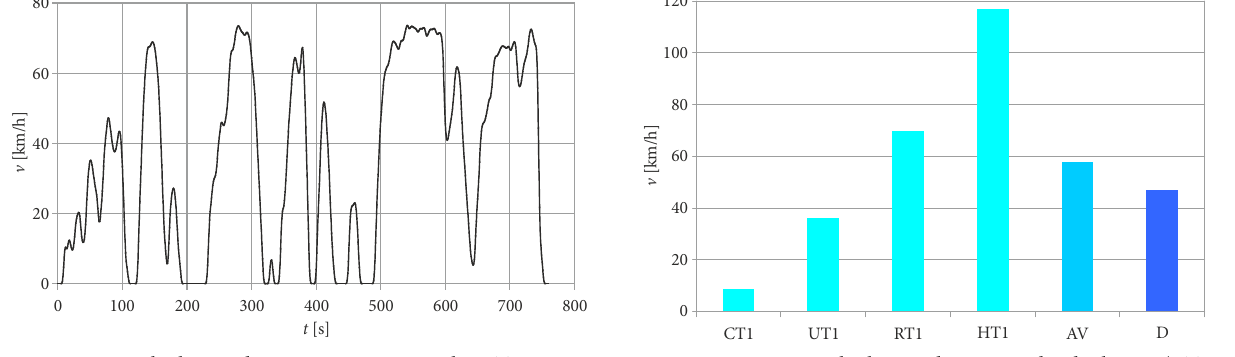
Figure 7. Vehicle speed v vs. time t curve in the UT1